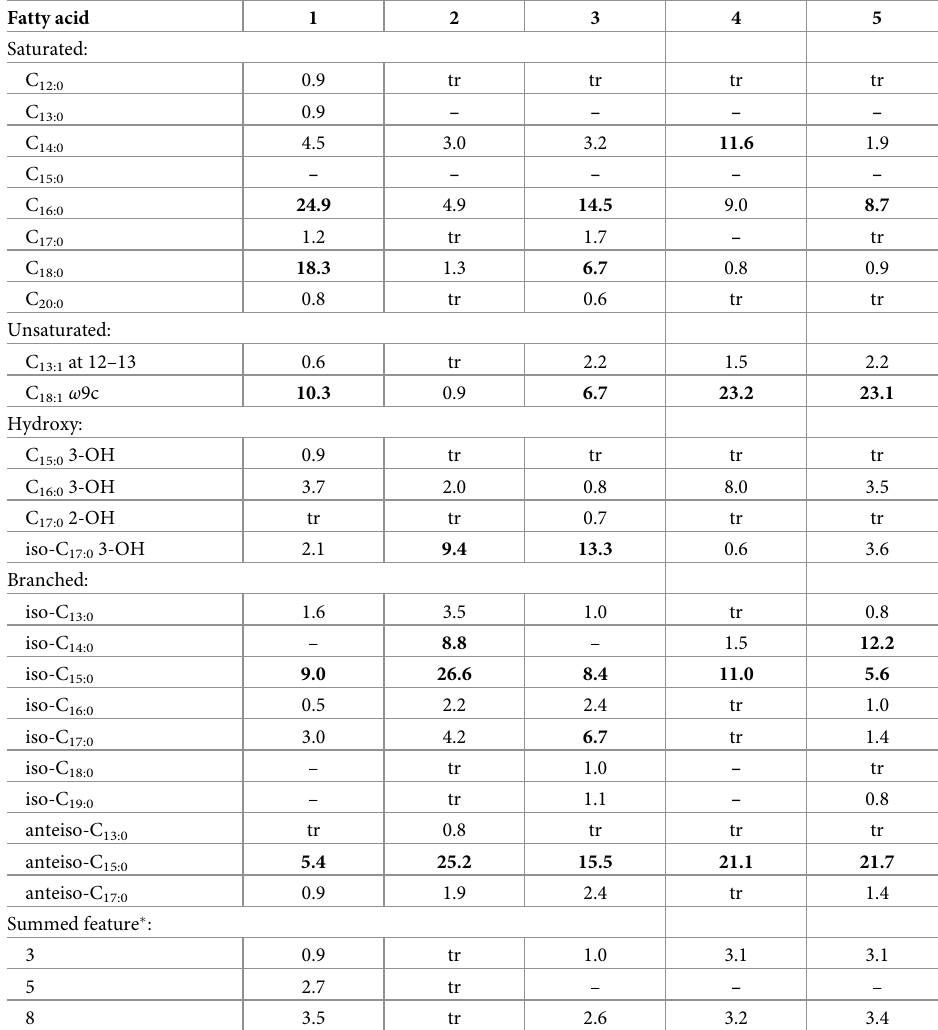
Table 2. Cellular fatty acid compositions (%) of strain E39 T and closely related